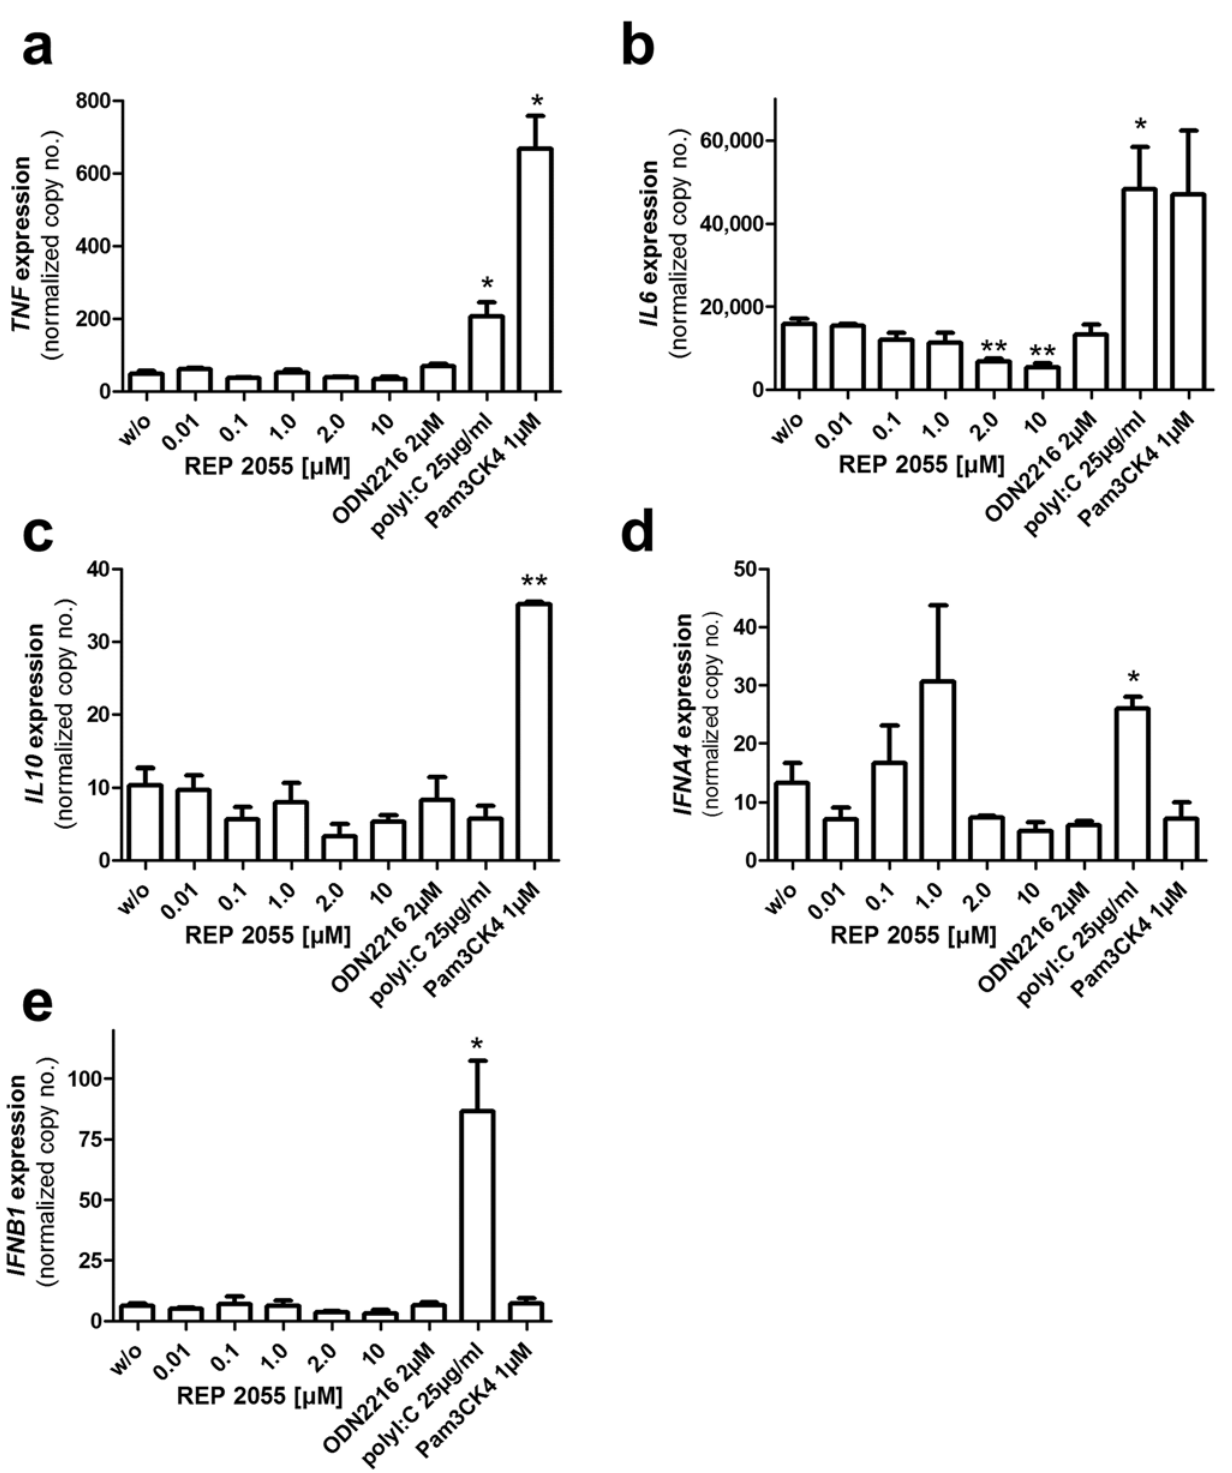
Fig 2. Lack of cytokine gene upregulation in PHH treated with REP 2055. The expression levels of TNF (a), IL6 (b), IL10 (c), IFNA4 (d) and IFNB1 (e) genes were assessed by quantitative RT-PCR 6 hr after treatment with the NAP REP 2055 (0.01 – 10 μ M) or without treatment (w/o), ODN 2216 (a CpG oligonucleotide TLR-9 agonist; 2 μ M), poly I:C (a double stranded RNA TLR-3 agonist; 25 μ g/ml) or Pam3CK4 (a TLR-1/2 agonist; 1 μ M). Values represent mean ± SEM (normalized to 100,000 copies of beta actin mRNA). Statistically significant changes compared to untreated controls are reported for p < 0.05 ( * ) and p < 0.01 ( **